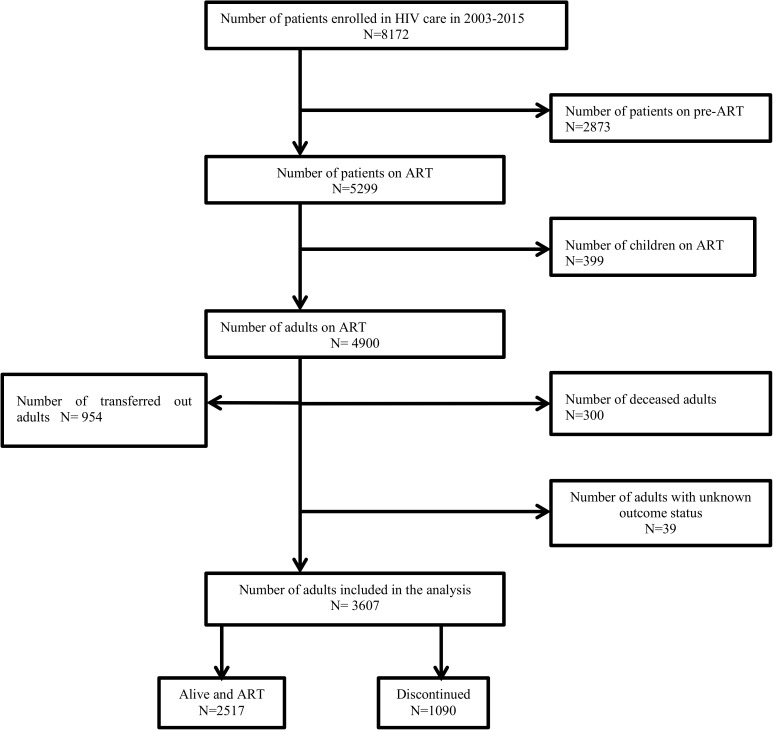
Schematic presentation of data extraction of ART discontinuation among HIV-infected adults in Jimma University Teaching Hospital, Southwest Ethiopia, 2003–2015.This figure presents the graphical demonstration of the data extraction process.